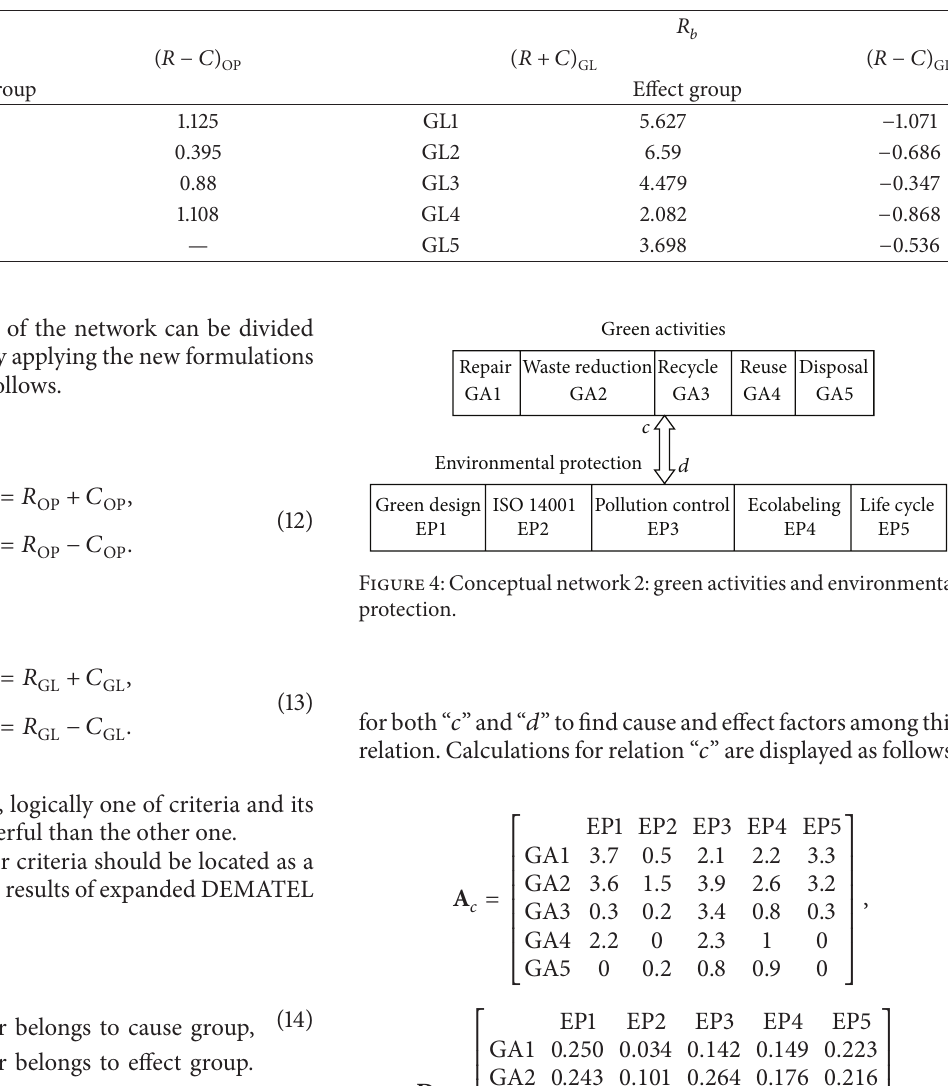
Table 1: Result of expanded DEMATEL for network 1.